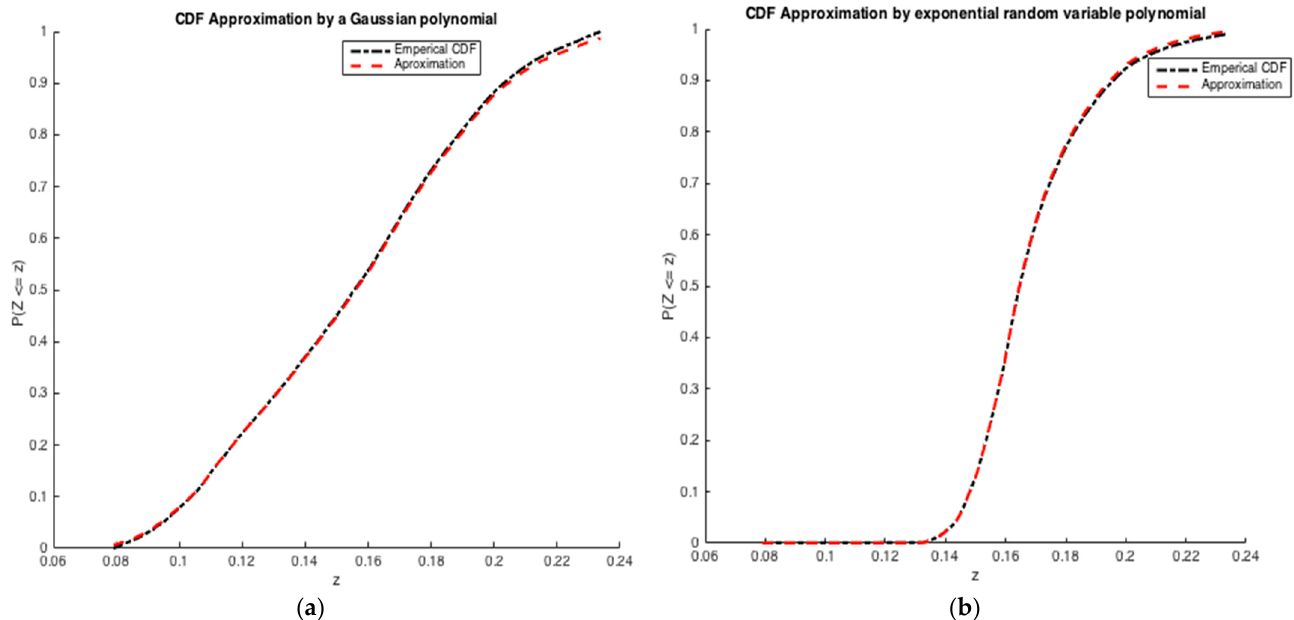
Table 3. Coefficients found in the second example by COL.